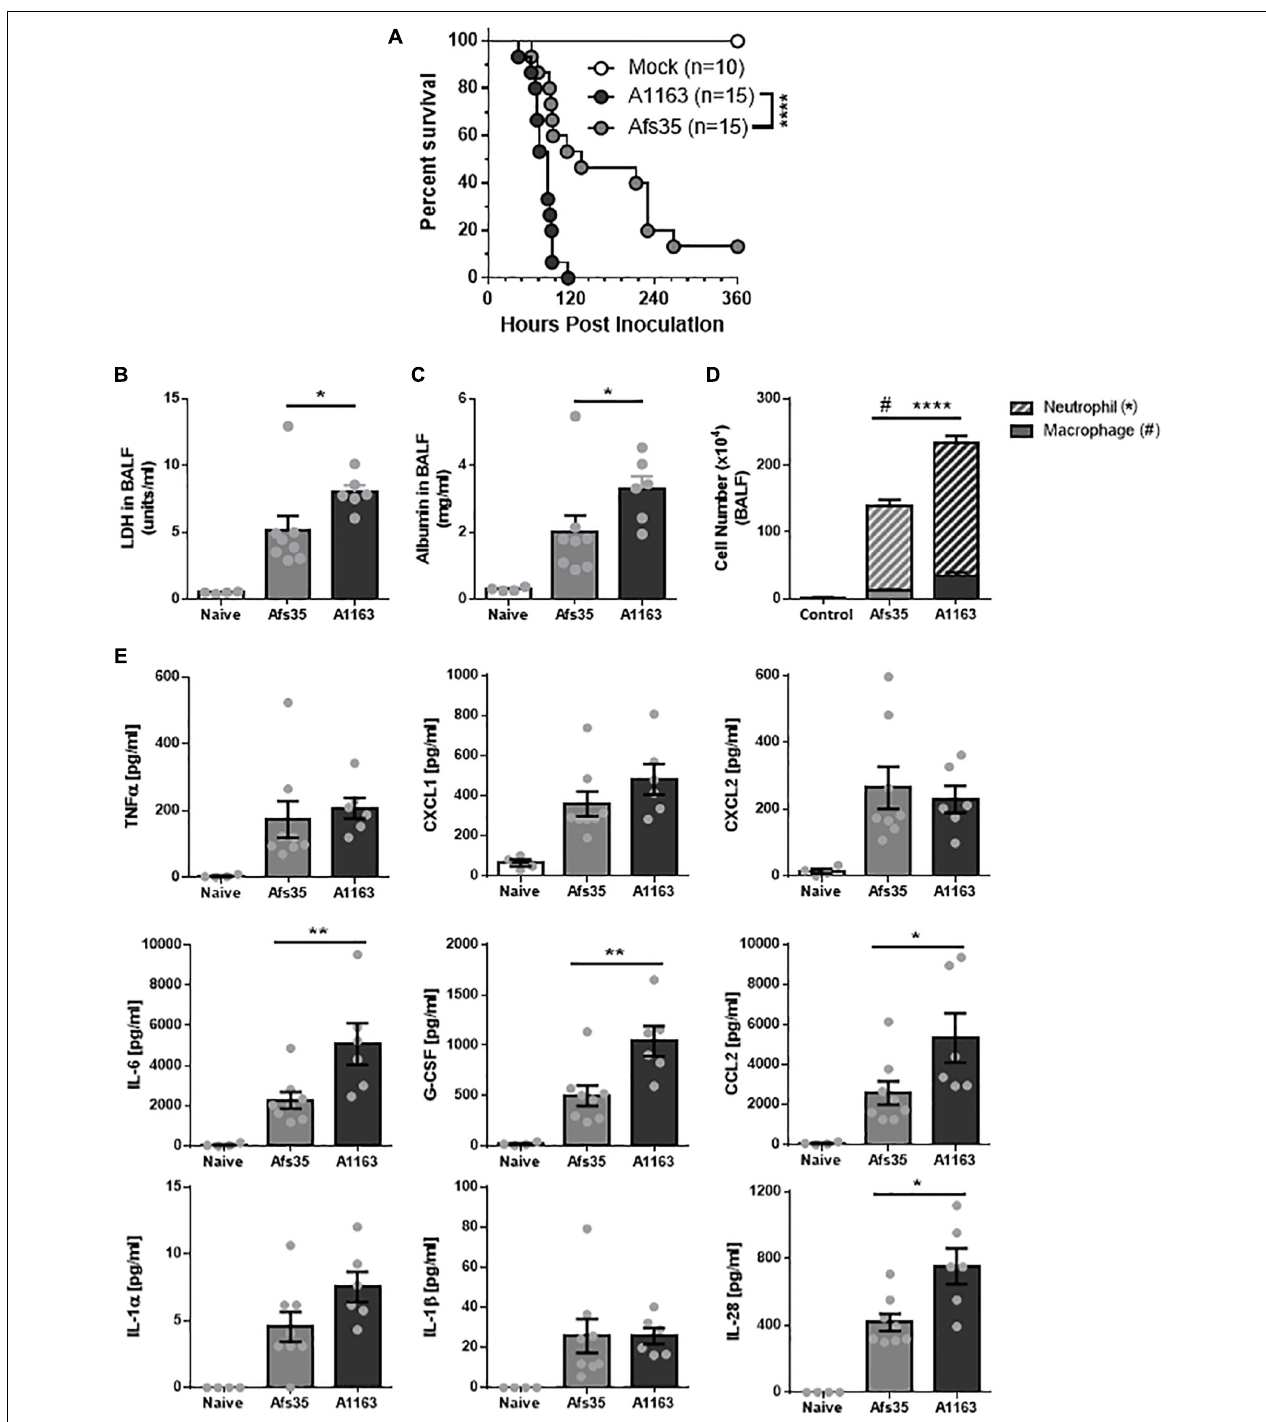
FIGURE 7 | Strain A1163 is more virulent than strain Afs35 in a triamcinolone murine model of pulmonary aspergillosis (PA). (A) Survival curve of triamcinolone-treated mice infected with phosphate buffered saline (PBS = mock, control) and strains A1163 and Afs35 for 15 days. 15 ( n ) mice were infected with each strain and log-rank test was used ( ∗∗∗∗ p < 0.0001) to assess statistical differences. (B) Lactate dehydrogenase activity, (C) albumin concentrations, and (D) number of macrophages and neutrophils in bronchoalveolar lavage fluid (BALF) 72 h after mice were infected with PBS (naïve) or strains A1163 and Afs35 ( # p < 0.05 refers to macrophage numbers and ∗∗∗∗ p < 0.0001 refers to neutrophil numbers). (E) Chemokine and cytokine profile of BALF and lung homogenate in mice 72 h post-infection with either PBS (naïve), strain A1163 or strain Afs35. Error bars indicate the mean ± SD (standard deviation) from three independent biological replicates. ∗ p < 0.05, ∗∗ p < 0.01, ∗∗∗ p < 0.001, and ∗∗∗∗ p < 0.0001 from a one-way ANOVA test with Dunn’s post-test.